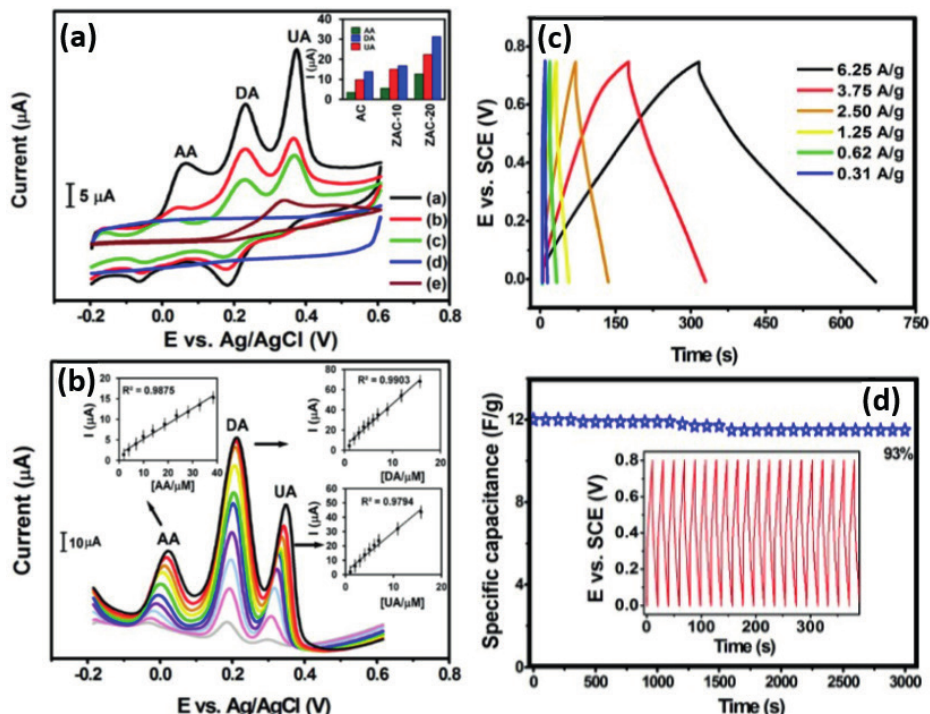
Figure 4 - Modified glassy carbon electrode (GCE) combining activated carbon and zinc oxide (ZAC) at different proportions for applications in sensing toward AA, DA and UA detection ( a and b ), and for energy storage as supercapacitor ( c and d ). Modified with permission from Madhu et al. (2016). Copyright 2016 Royal Society of